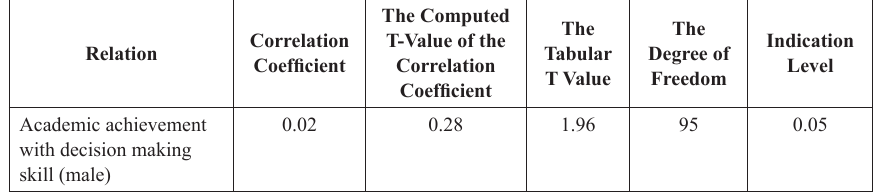
Table 8. Correlation coefficients between decision-making skill & academic achievement and the significance of correlation when at research sample The Computed Correlation T-Value of the Relation Coefficient Correlation